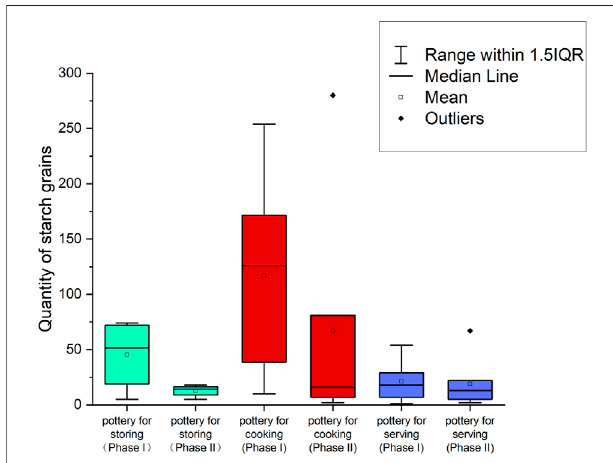
FIGURE5| Quantitiesofstarchgrainsdetected on potsherdsattributed to Phase I and Phase II of Houjiazhai.